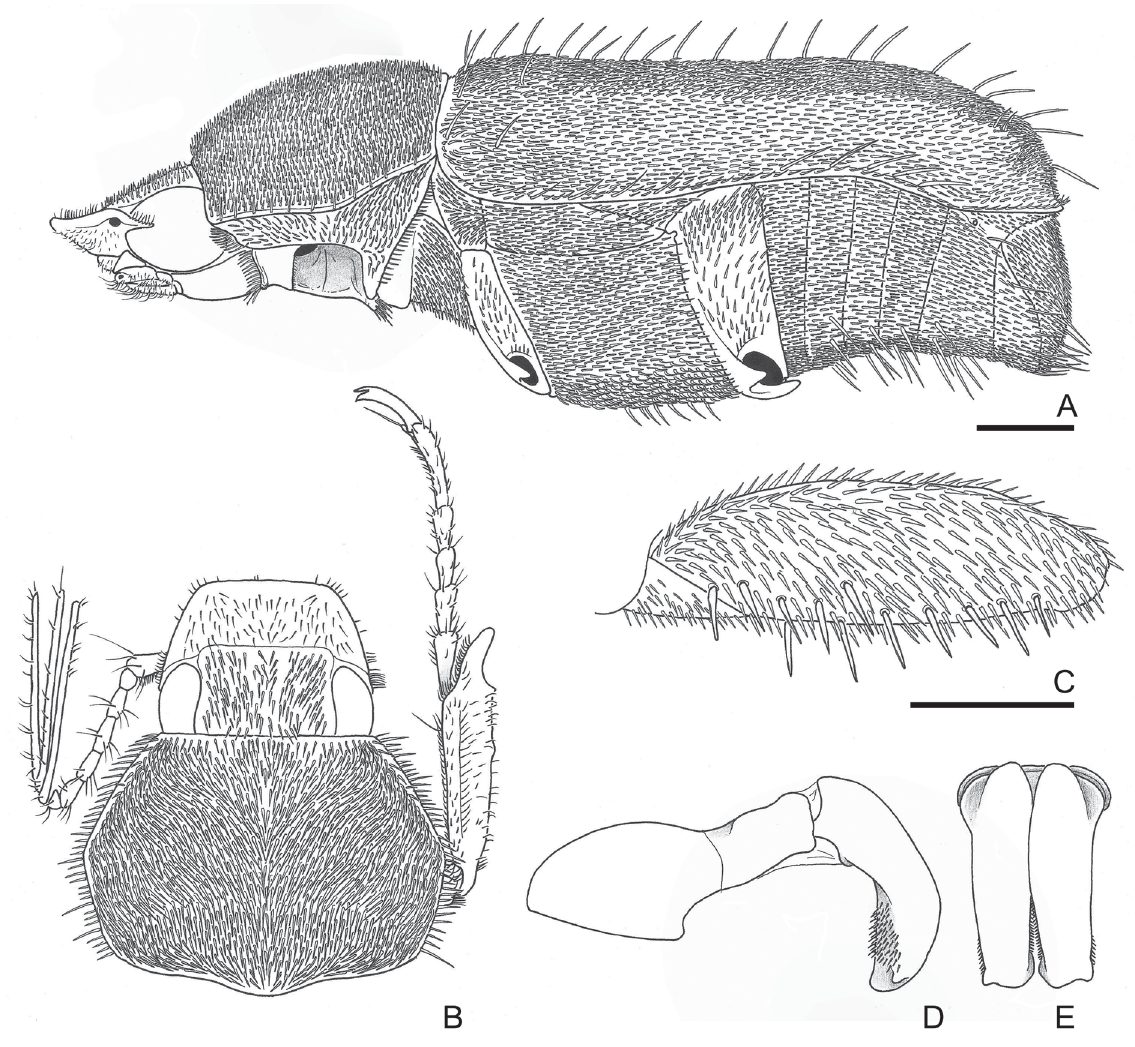
Fig. 3. Alvarinus canescens Burmeister, 1855, ♂. A . Habitus, lateral (without some appendages). B . Head–prothorax dorsal, tarsus rotated laterally to apex. C . Metafemur. D–E . Aedeagus (lateral, parameres apex). Scale bars =